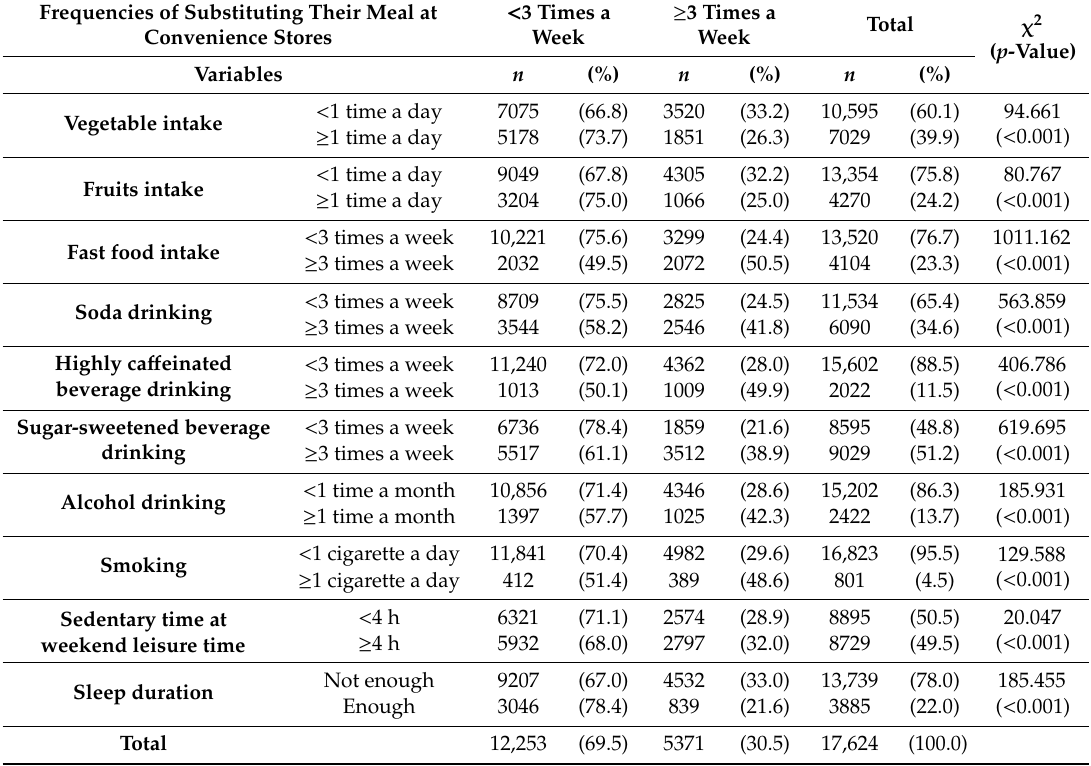
Table 2. Di ff erences in Frequencies of Substituting Meals for Convenience Store Food According to Lifestyles of Study